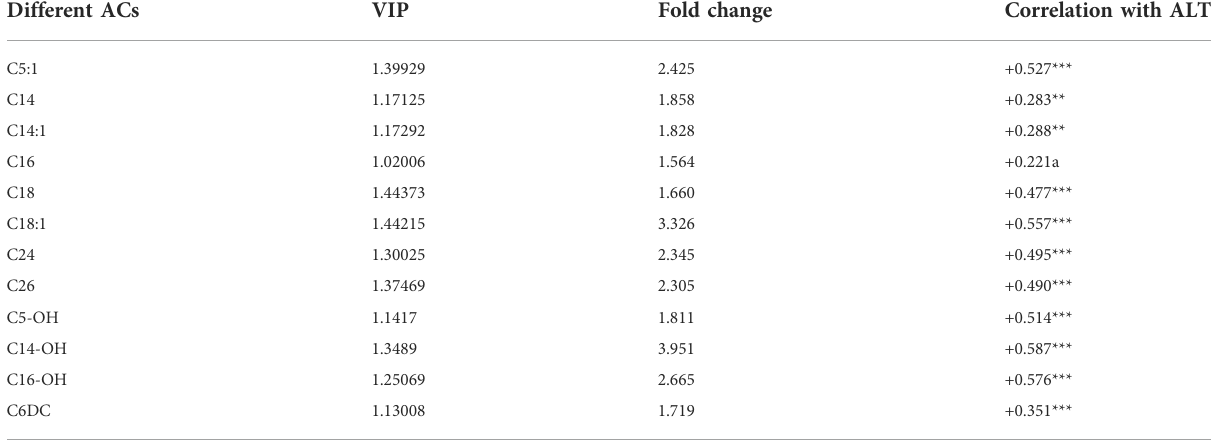
TABLE 1 Identifcation of the most differential ACs between ALF and NLF groups. Different ACs VIP Fold change Correlation with